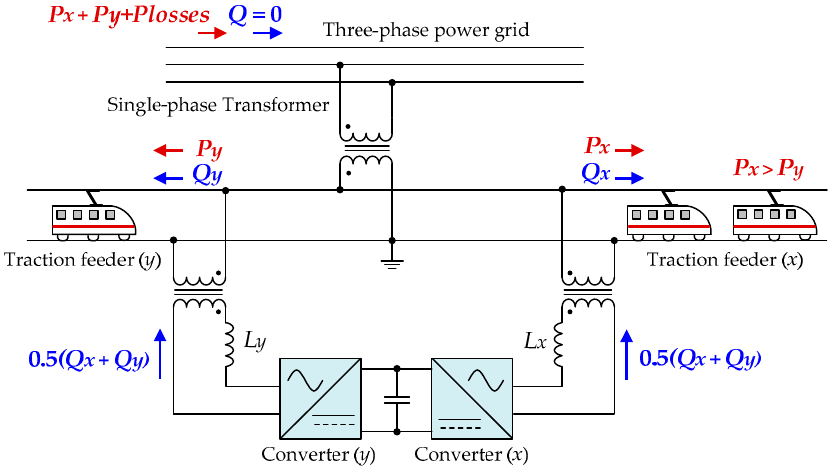
Figure 3. RPC operating in SVC mode (RPC based SVC) (based on [40]). Table 1. Capabilities of RPC operating in SVC mode.